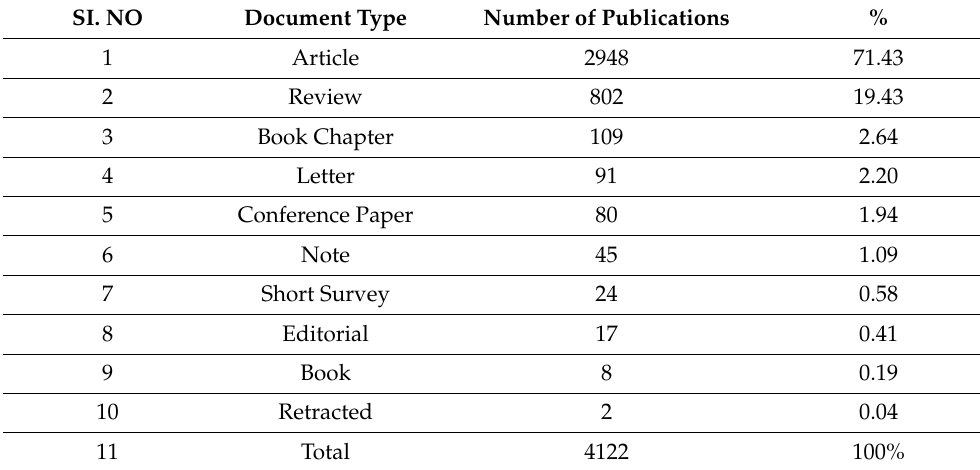
SI. NO = Serial Number.